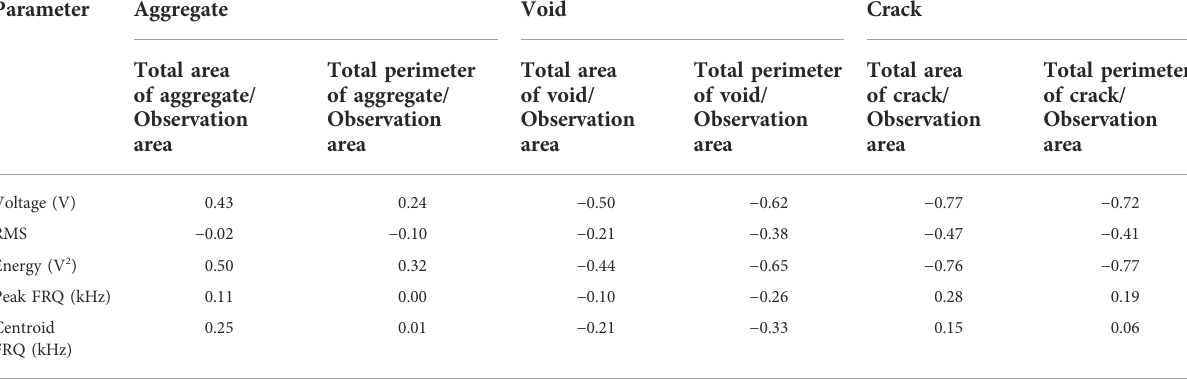
TABLE 7 Correlation between proportions parameters of concrete components and AU